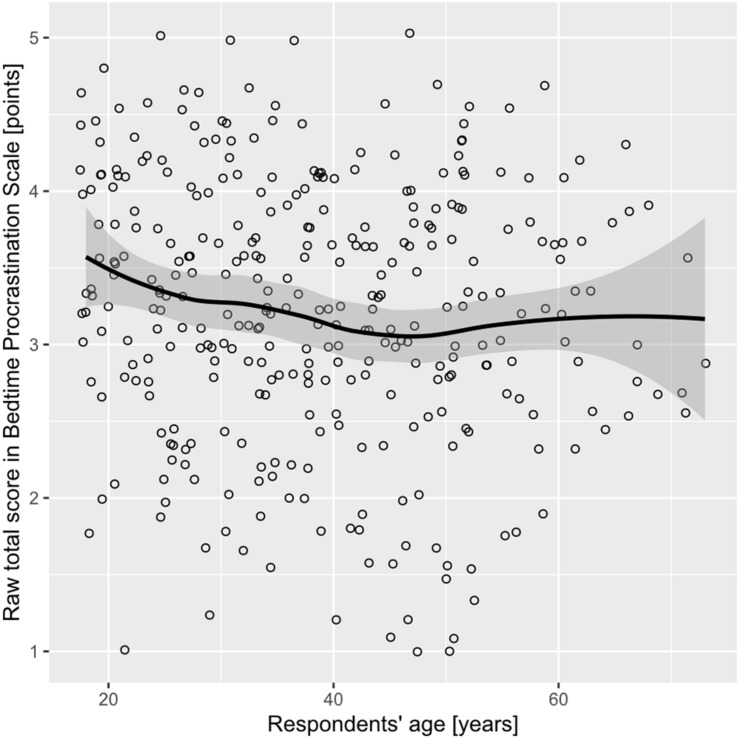
Scatterplot of raw total scores in BPS by respondents’ age with smoothed regression line and 95% confidence interval in Sample 2. The loess function was used for smoothing.